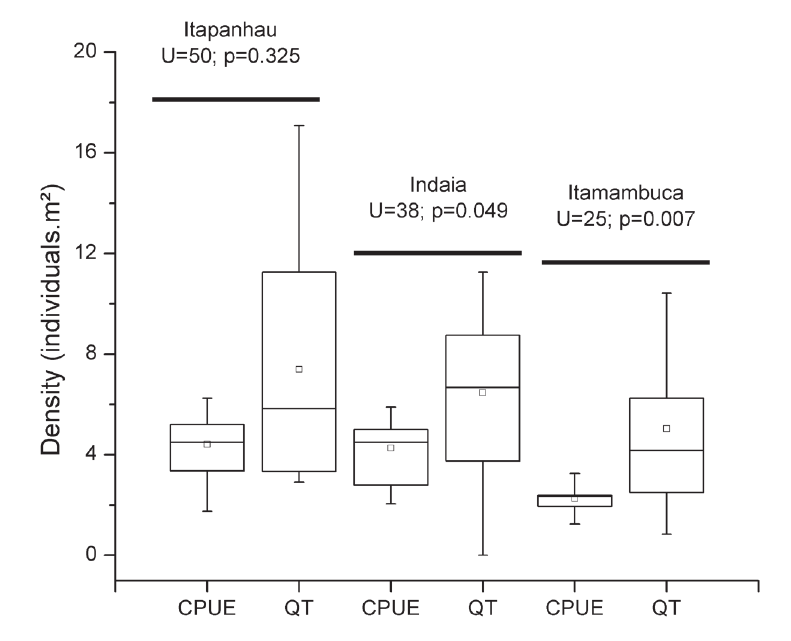
Figure 3. Minuca vocator (Herbst, 1804). Density comparisons (fiddler crab .m²) between sampling procedures, within each